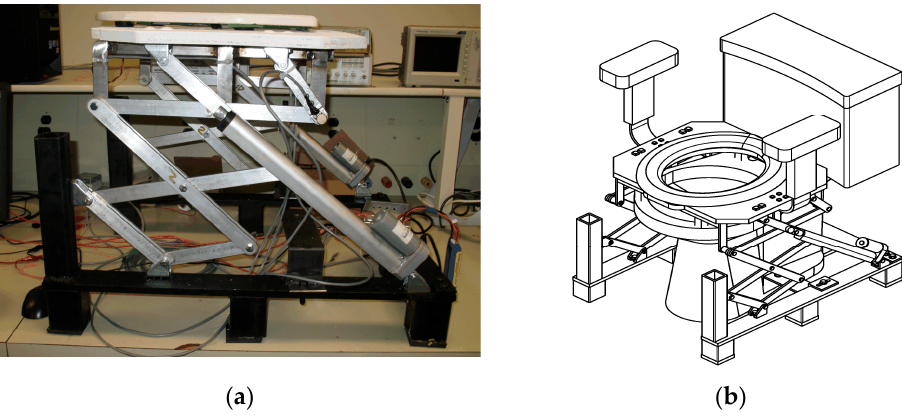
Figure 2. ( a ) Assistive system installed on the toilet final prototype; ( b ) Assistive system installed on the toilet designed in SolidWork.